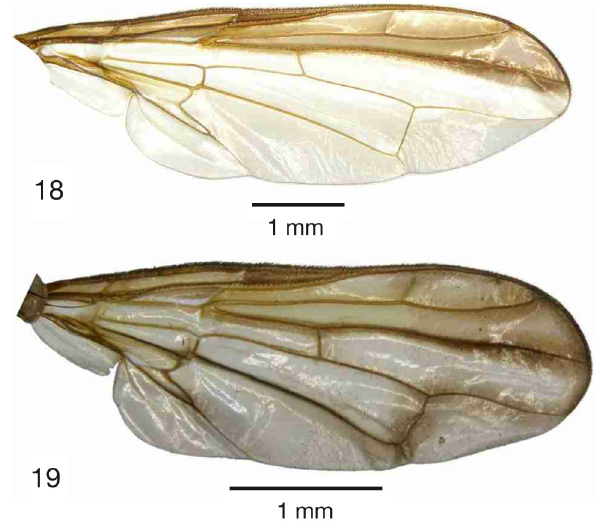
Figs 18–19. Ichneumonopsis spp., wing. 18 . I. burmensis Hardy, 1973. 19 . I. taiwanensis